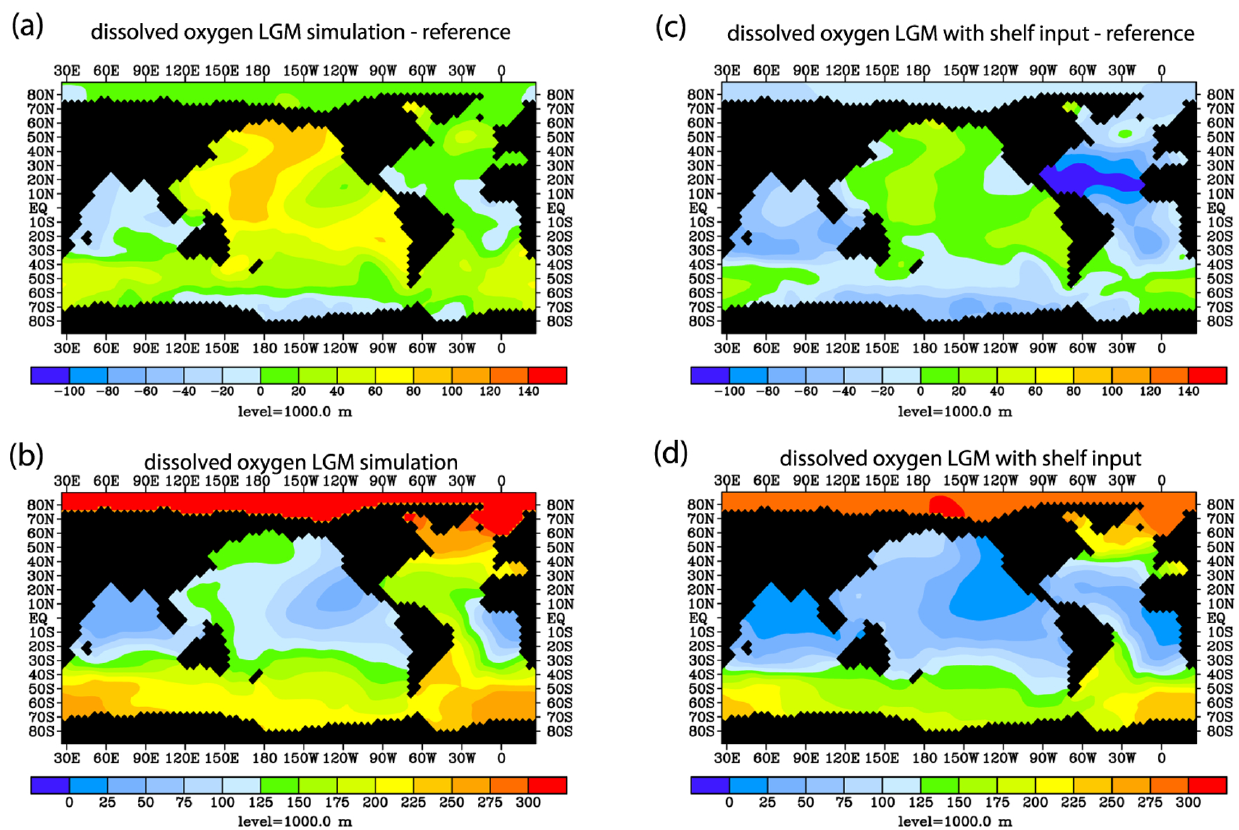
Fig. 6. Oxygen anomalies at 1000 m relative to the reference run in the model (a) LGM simulation and (c) LGM simulation with shelf input. Oxygen concentrations at 1000m in the model (b) LGM simulation and (d) LGM simulation with shelf input. Units in µmoll − 1